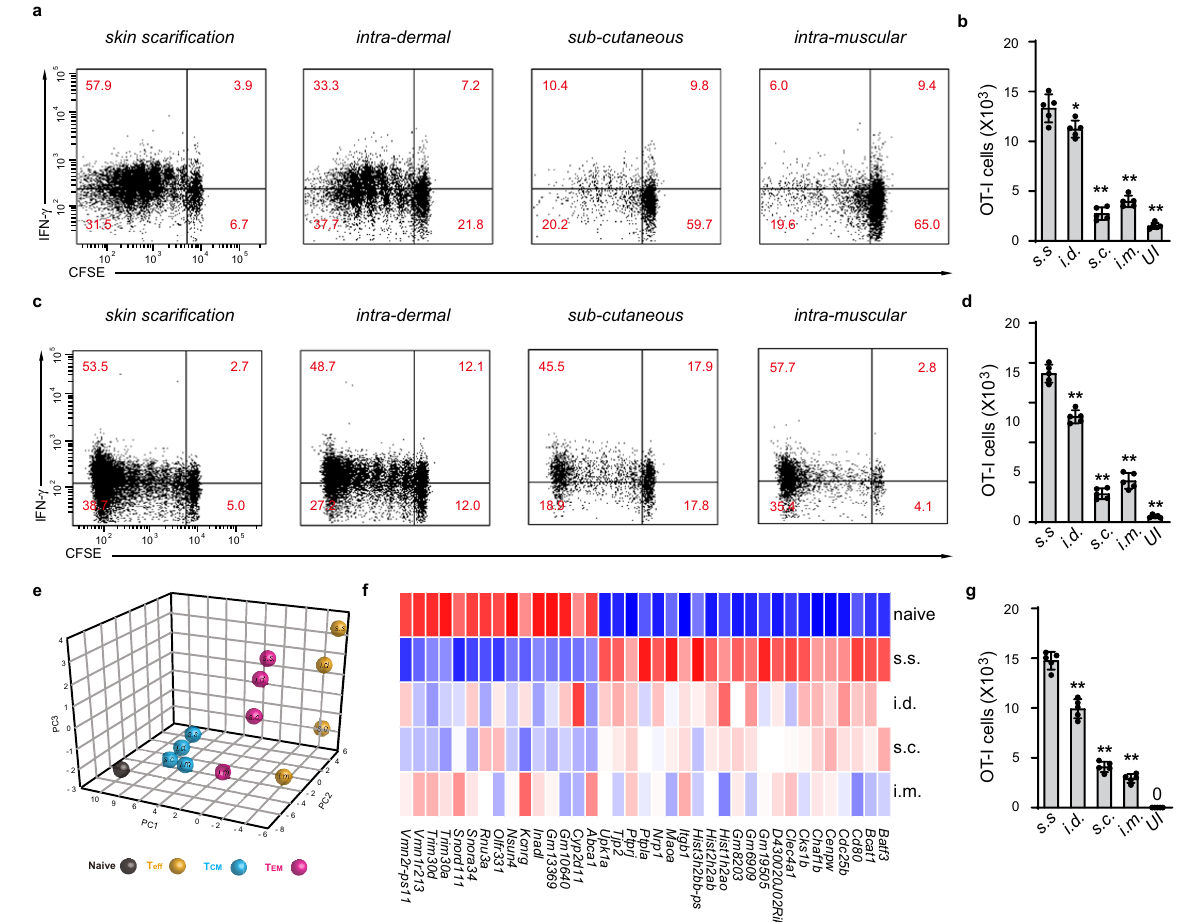
Fig. 2 Delivery of MVA via s.s. generates T cells that are both quantitatively more abundant and qualitatively distinct from those generated from i.d., s.c., and i.m. a – d Flow cytometric analysis ( a , c ) and quanti fi cation ( b , d ) of OT-I cell proliferation in draining lymph nodes of recipient mice at 60 h ( a , b ) and 5 days ( c , d ) post MVA infection via different routes. CFSE-labeled naive OT-I Thy1.1 + cells were transferred into Thy1.2 + recipient mice 1 day before mice were infected with 1.8 × 10 6 pfu MVA-Ova via indicated infection routes. e Principal component analysis (PCA) of gene expression for T cells generated by MVA infection via different routes. Naive T cells (T N ) were sorted from the peripheral lymph nodes of naive OT-I mice. Effector T cells (T eff ) were sorted from draining lymph nodes at 5 days post infection. Central memory T cells (T CM ) and effector memory T cells (T EM ) were sorted from the spleen of mice at 45 days post infection. Each dot represents an individual experiment wherein mRNA was pooled from 15 to 20 mice from 3 to 4 independent biological groups (5 mice/group). f Heatmap of differentially expressed genes selected from a pairwise comparison between s.s. generated T eff cells and naive T cells. g Quanti fi cation of skin in fi ltrating T cells at day 5 post 1.8 × 10 6 pfu MVA-Ova infection via indicated routes. a , c Data are representative of three independent experiments ( n = 5 mice per group). b , d , g Unimmunized (UI) mice were included as controls. Graphs show mean ± SD ( n = 5). * p < 0.05, ** p <